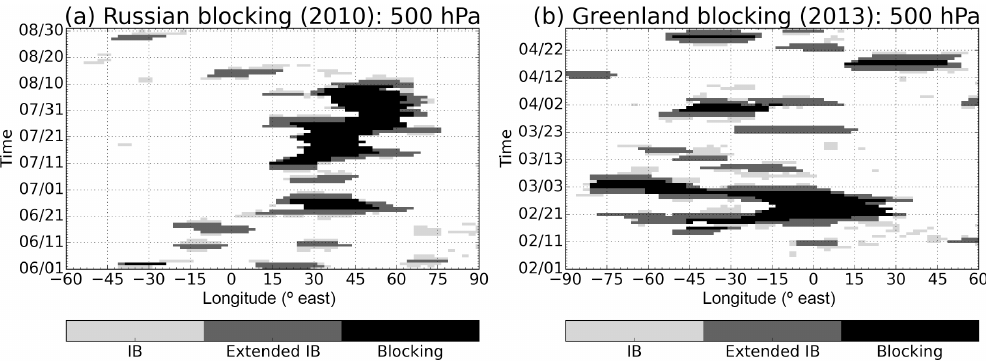
Figure 3. Hovmöller diagrams of observed blocking occurrence at 500hPa over (a) Russia in June–July–August (JJA) 2010 and over (b) Greenland in February–March–April (FMA) 2013. Blocking is considered between 50 and 65 ◦ N. Shading indicates the three blocking detection steps: IB (light gray), extended IB (dark gray), and blocking